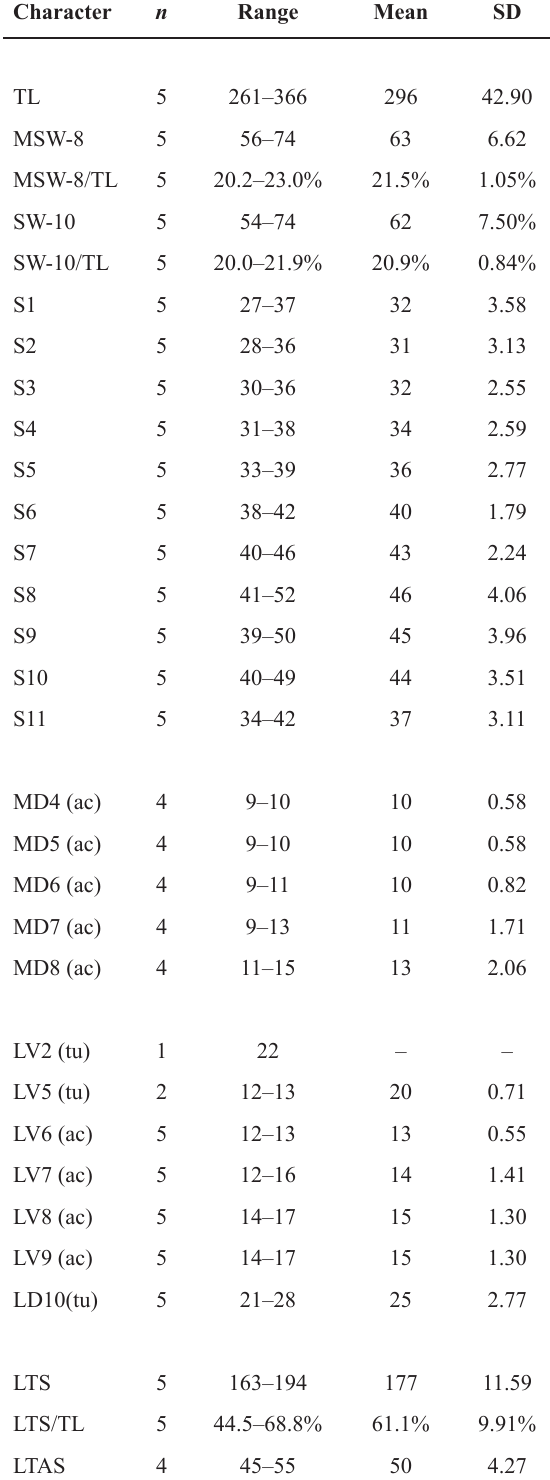
Table 17. Measurements from light microscopy for Echinoderes chandrasekharai Sørensen & Chatterjee sp. nov. (in µm), including number of measured specimens ( n ) and standard deviation